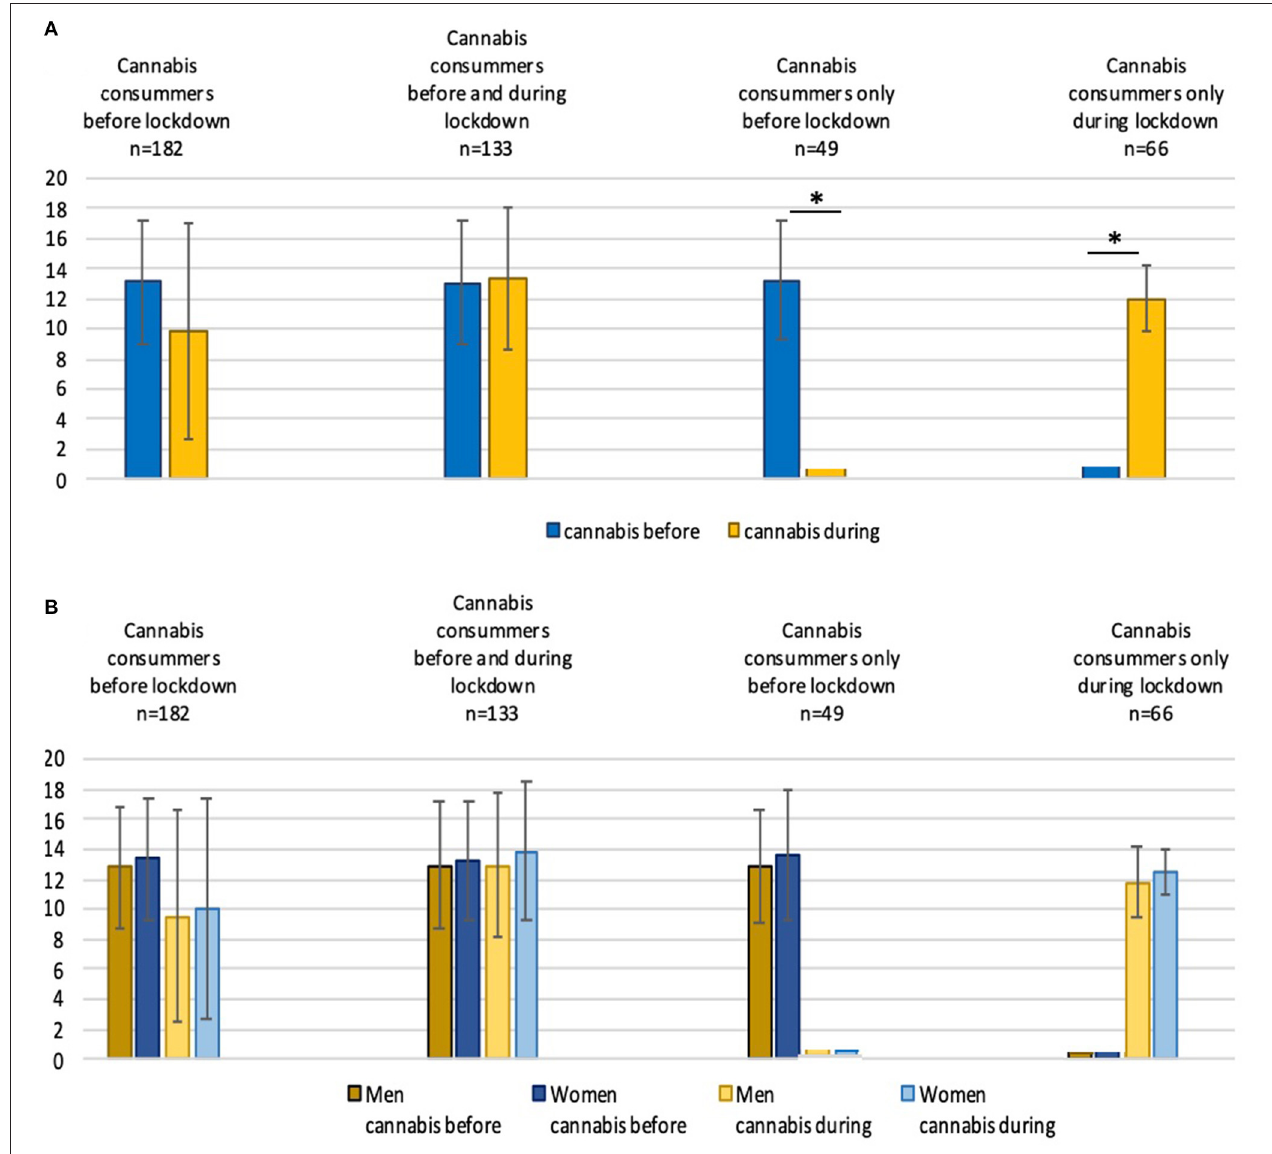
FIGURE 2 | (A) Comparison of the consumption of cannabis before and during the lockdown period in the overall group of cannabis users and the three subgroups. (B) Comparison of the consumption of cannabis before and during the lockdown in men and women. The ordinate represents the number of joints consumed per week * p <